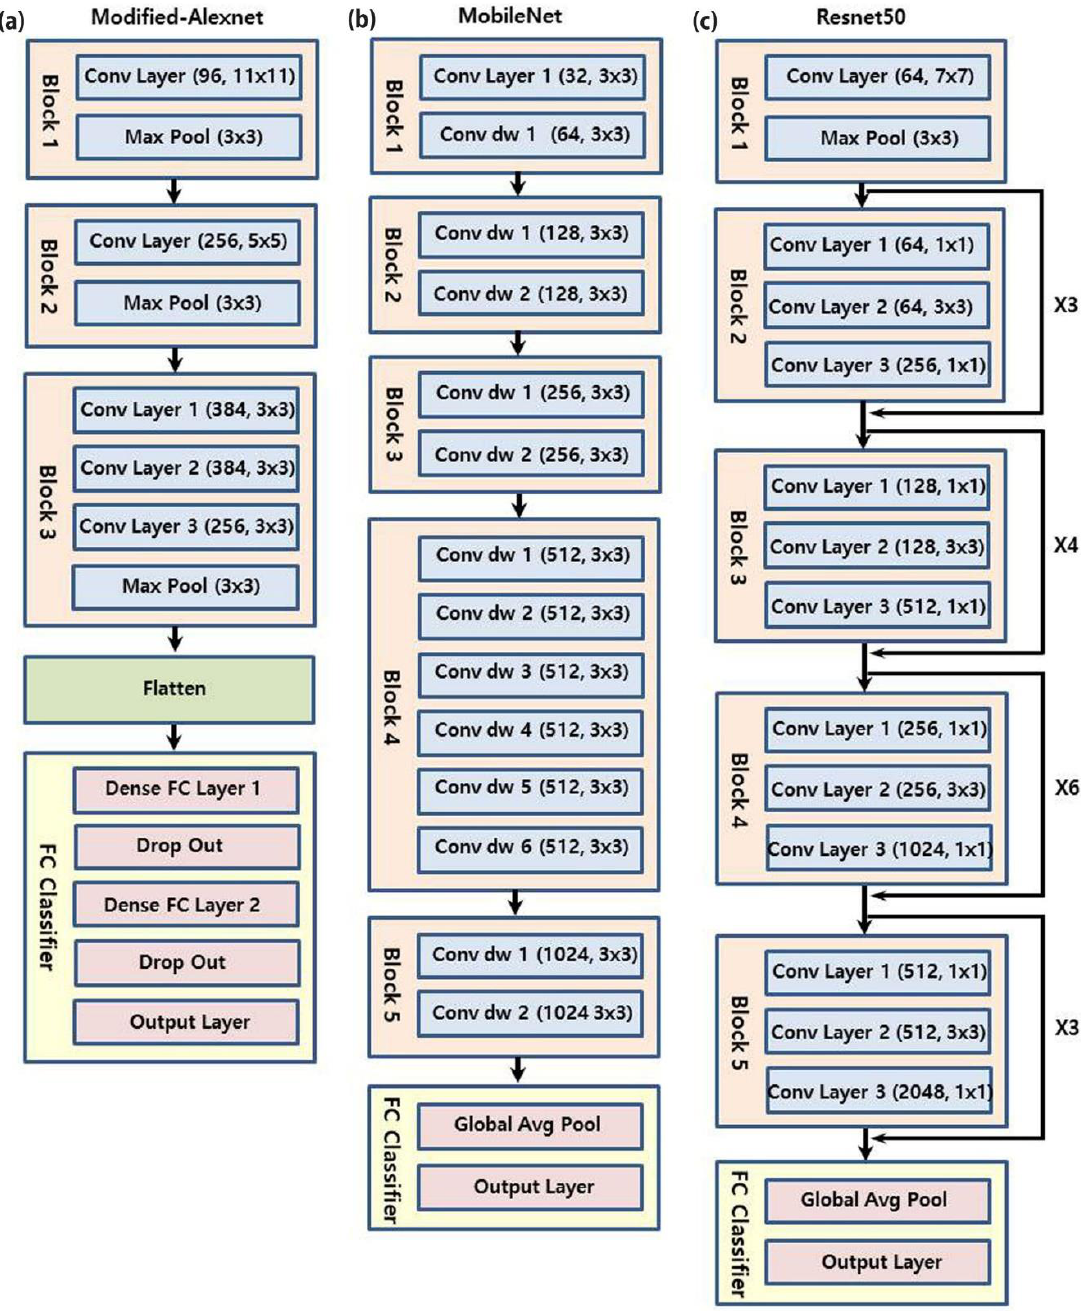
Figure 2. The three deep learning models used in this study were ( a ) Modified-Alexnet, ( b ) MobileNet, and ( c ) Resnet50.